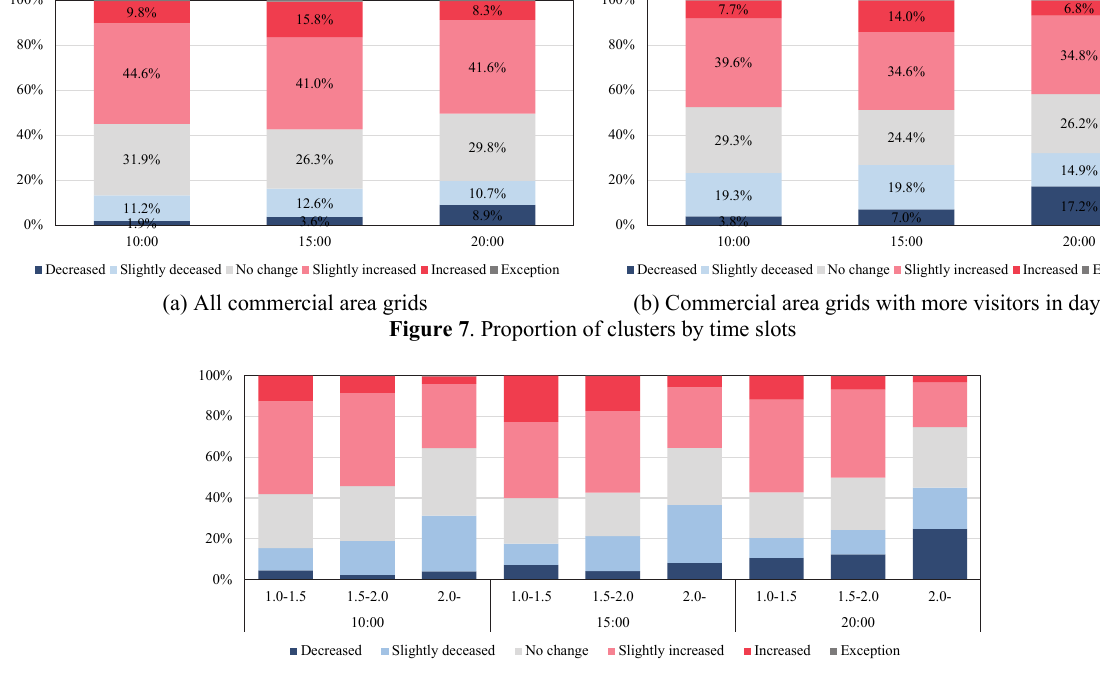
Figure 8 . Proportion of clusters by time slots and commercial density level